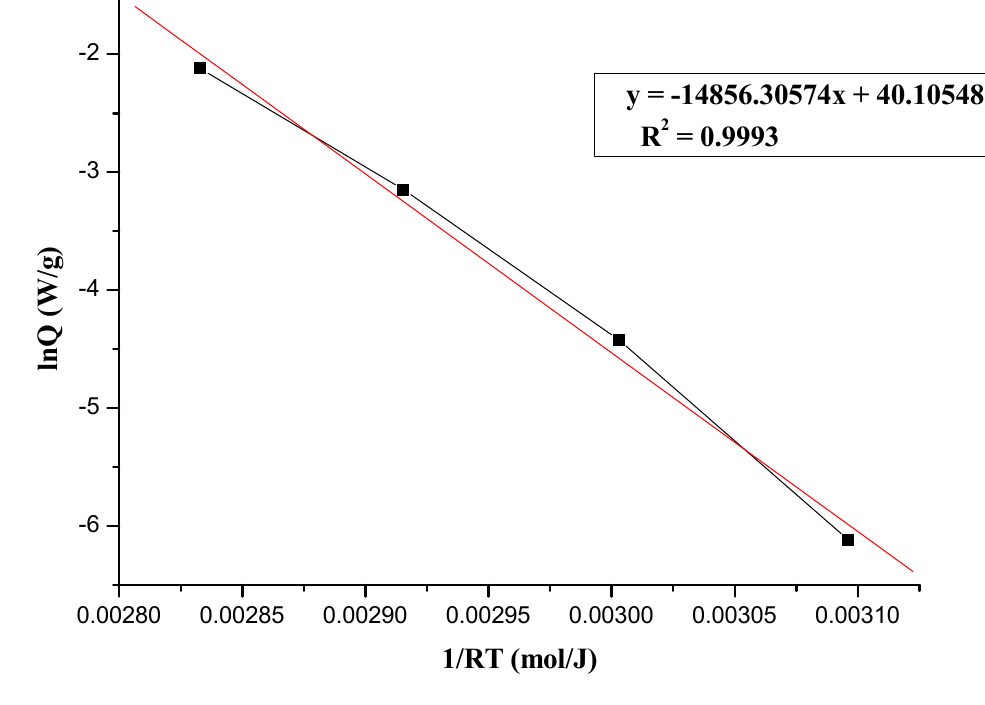
Figure 3. Determination of activation energy from the slope of lnQ vs. 1/(RT) for the thermal decomposition of 95 mass% LPO with 1 N HNO TAM III tests.